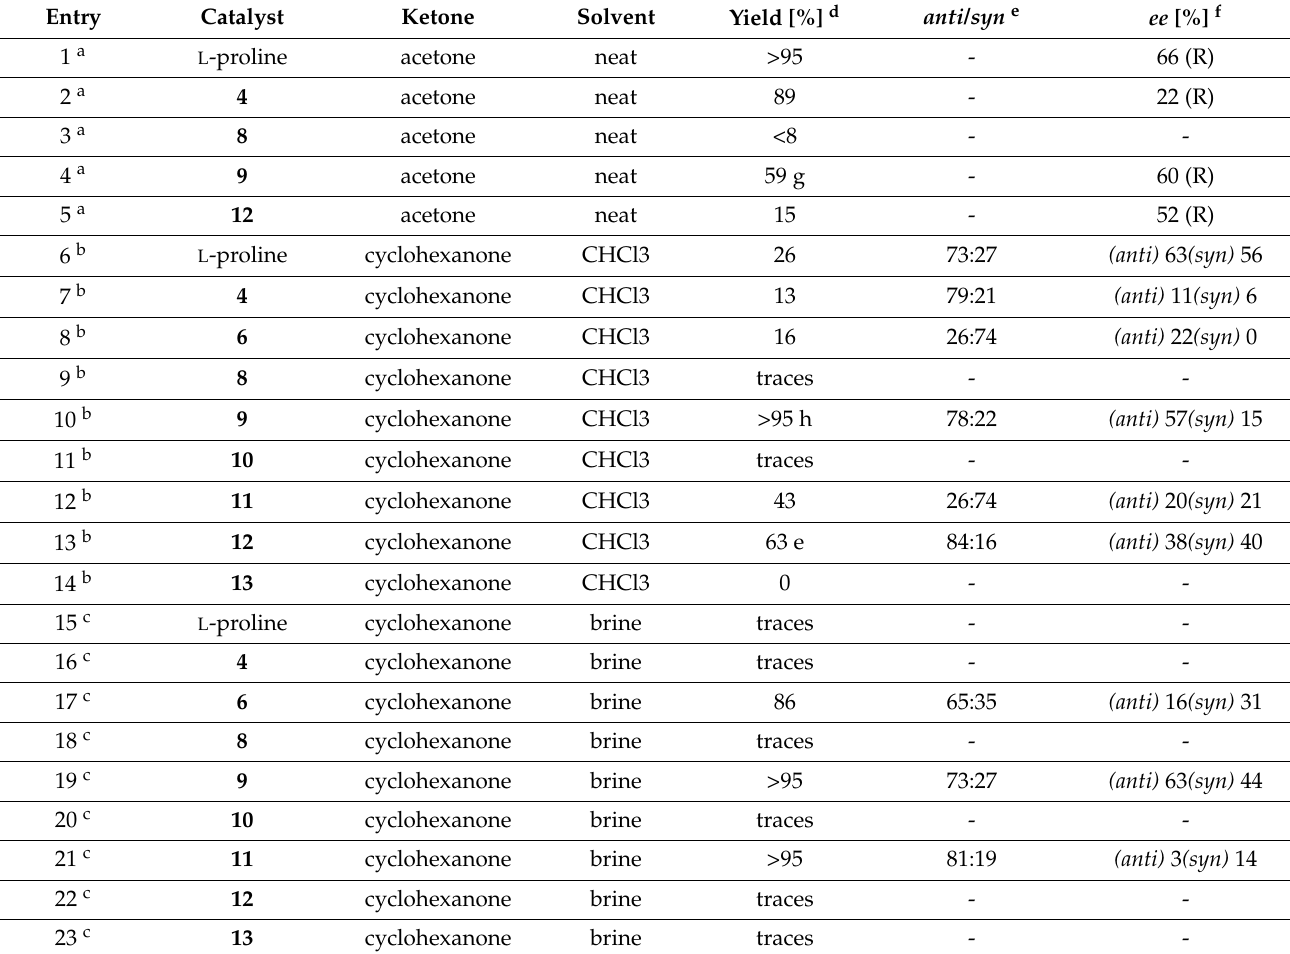
Table 1. Results of aldol reaction of 14a, b and 15 using organocatalysts 4 , 6 , 8–13 and L